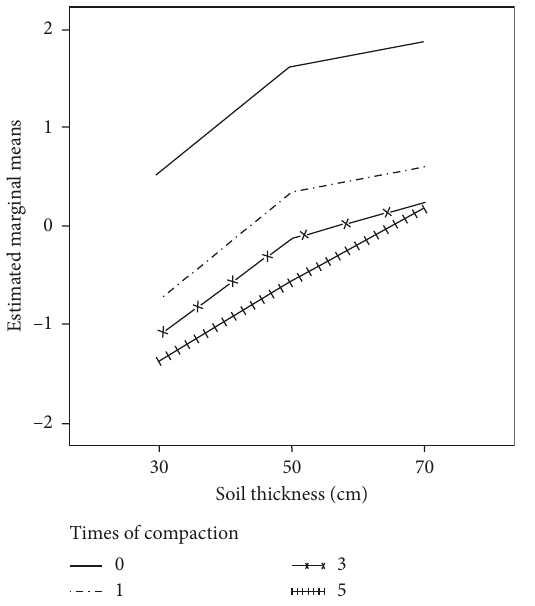
Figure 5: Estimated marginal means of impacts of times of compaction and soil thickness to porosity.